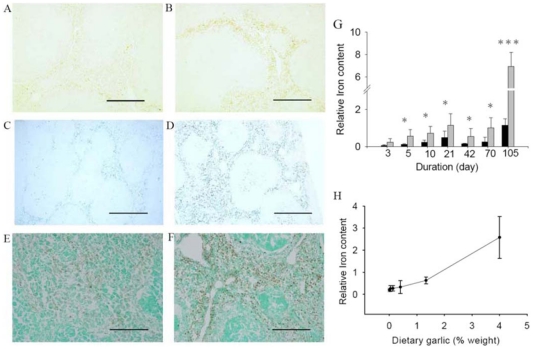
Histochemical phenotypes of spleens of C57BL/6J (n = 6) mice on cellulose-(A, C, E) and garlic-supplemented (B, D, F) diets (week 15).Spleen sections were shown with no staining (A, B) to reveal bilirubin, with Prussian blue stain for Fe2+(C, D), and with Gomori stain for macrophages via acid phosphatase and counter-stained for nuclei with methyl green (E, F). (G) Time course (n = 4) of Fe2+ accumulation in the spleens due to dietary garlic (4%). (H) Dose-response (n = 6) of dietary garlic in spleen sections. Scale bars represent 200 µm (A–F). (Statistics: *, p<0.05; ***, p<0.005, student's t test). Black bars: control; gray bars: garlic diet.